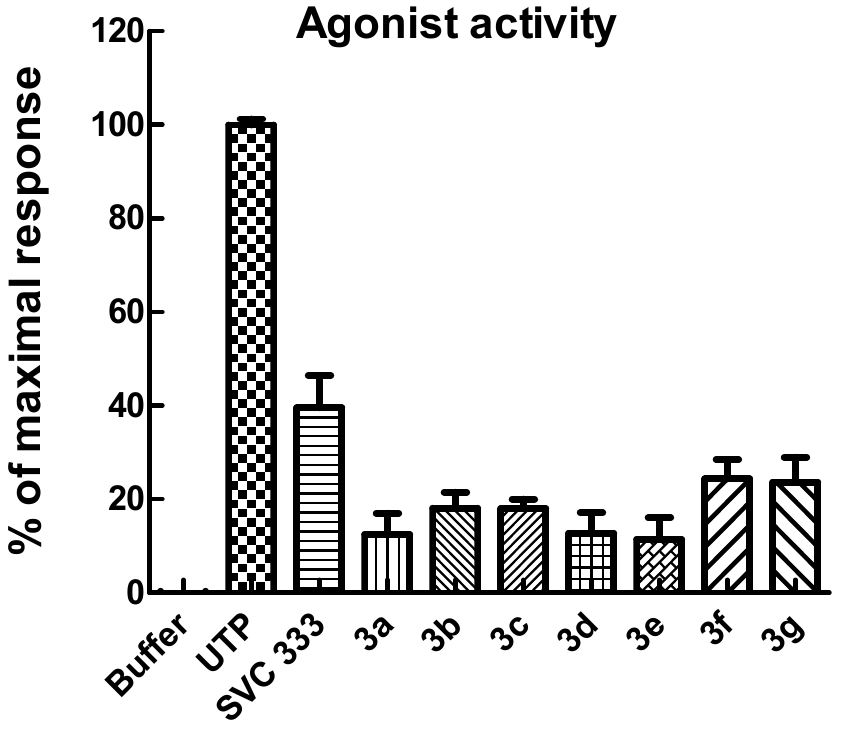
agonists for 30 min at 37 °C in the presence of 10 mM LiCl, and inositol phosphate accumulation was quantified. The concentration of all phosphonate analagues was 30 μ M and of UTP was 3 μ M. The data are presented as the mean ± S.E.M. and are representative of results obtained in three separate